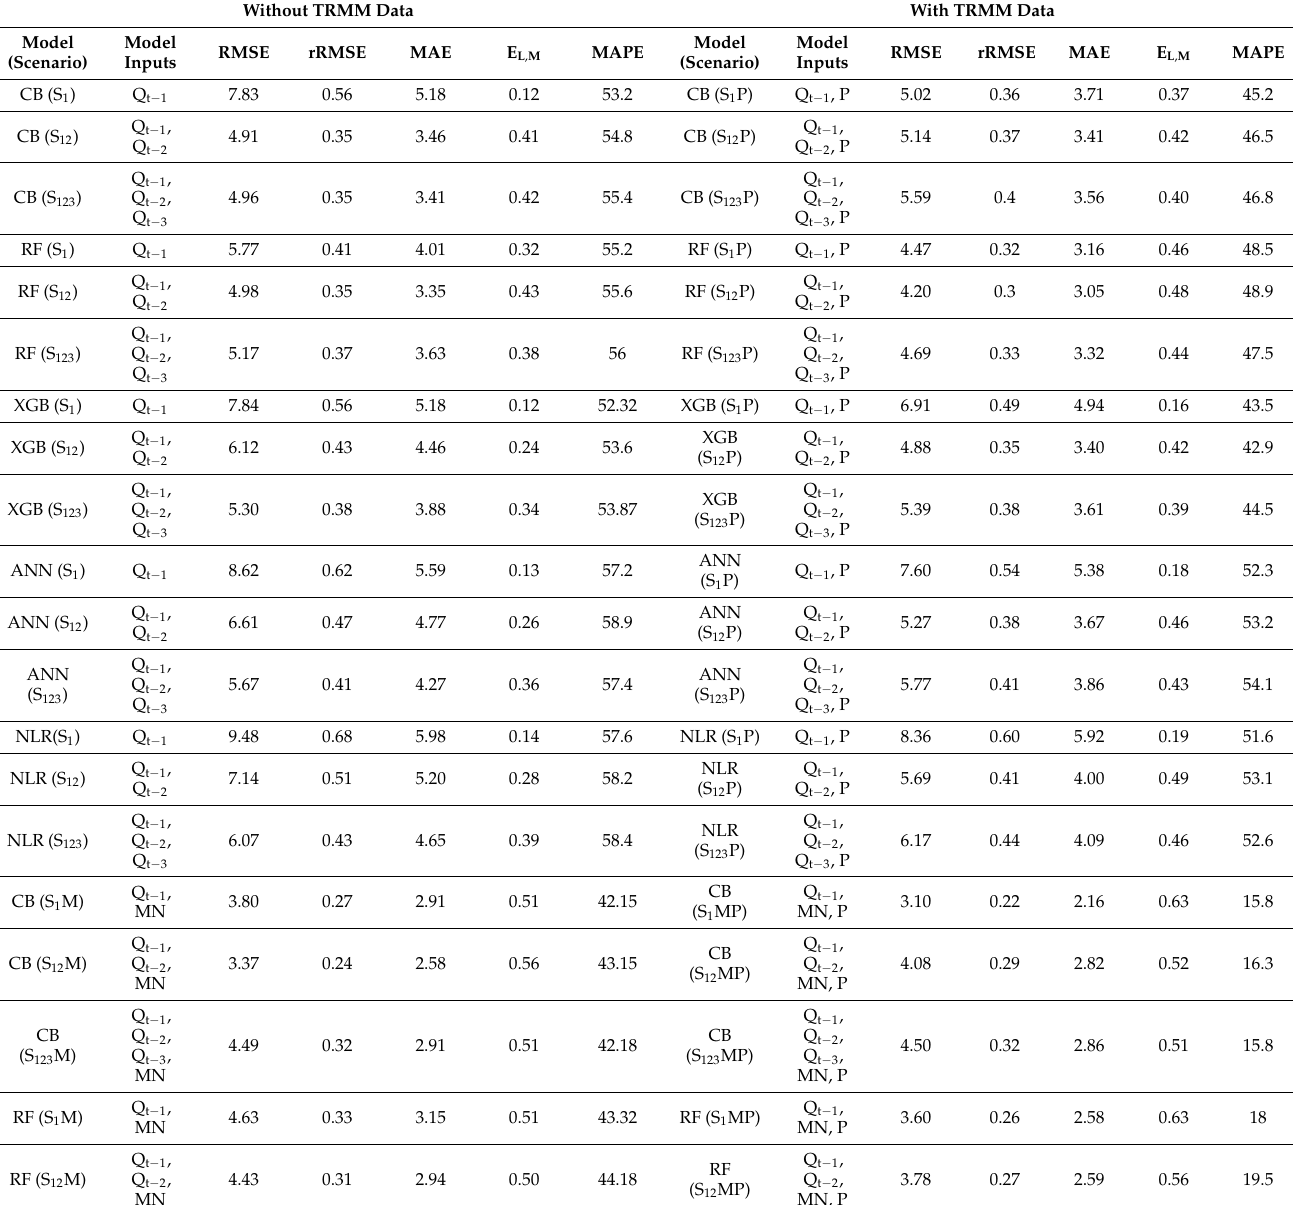
Table 3. The accuracies of the CB, RF, XGB, ANN and NLR methods in predictions of monthly streamflow at the Sutluce Station (Code: 1414) in the testing